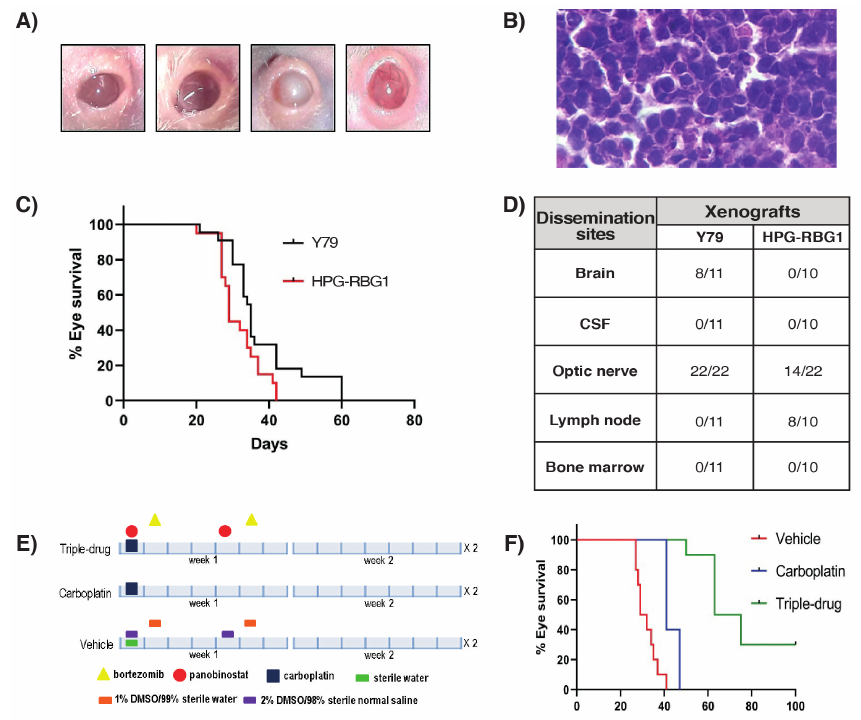
Figure 6. ( A ) Macroscopic assessment of tumor growth after intravitreal injection of HPG-RBG1 cells to immunodeficient mice. Progressive stages of tumor growth from stage 0 corresponding to the normal mouse eye to stage 1 showing small tumors in the posterior segment, stage 2 with the presence of tumor filling the full posterior segment and increase in the eye size, and stage 3 with eyes three-fold the normal size and proptosis; ( B ) Hematoxylin & eosin of the CDXs eye showing the same characteristics (large, anaplastic cells) as those observed for the orbital tumor of Patient 2 (40x); ( C ) Eye survival curves of HPG-RBG1 CDXs and the reference model Y79 (commercial cell line with MYCN ampl ) for n = 10–11 animals per group (log-rank test, p < 0.05); ( D ) Tumor dissemination pattern in Y79 and HPG-RBG1 CDXs ( n = 10 − 11 in each group) by RT-qPCR; ( E ) Experimental scheme design on the basis of in vitro sensitivity obtained by HTS and previous reports of pharmacologically attainable concentrations; ( F ) Eye survival curves of HPG-RBG1 after two cycles of vehicle, standard chemotherapy (carboplatin 34 mg/kg, ip), or the proposed chemotherapy treatment scheme for n = 5 animals per group (log-rank test, p <